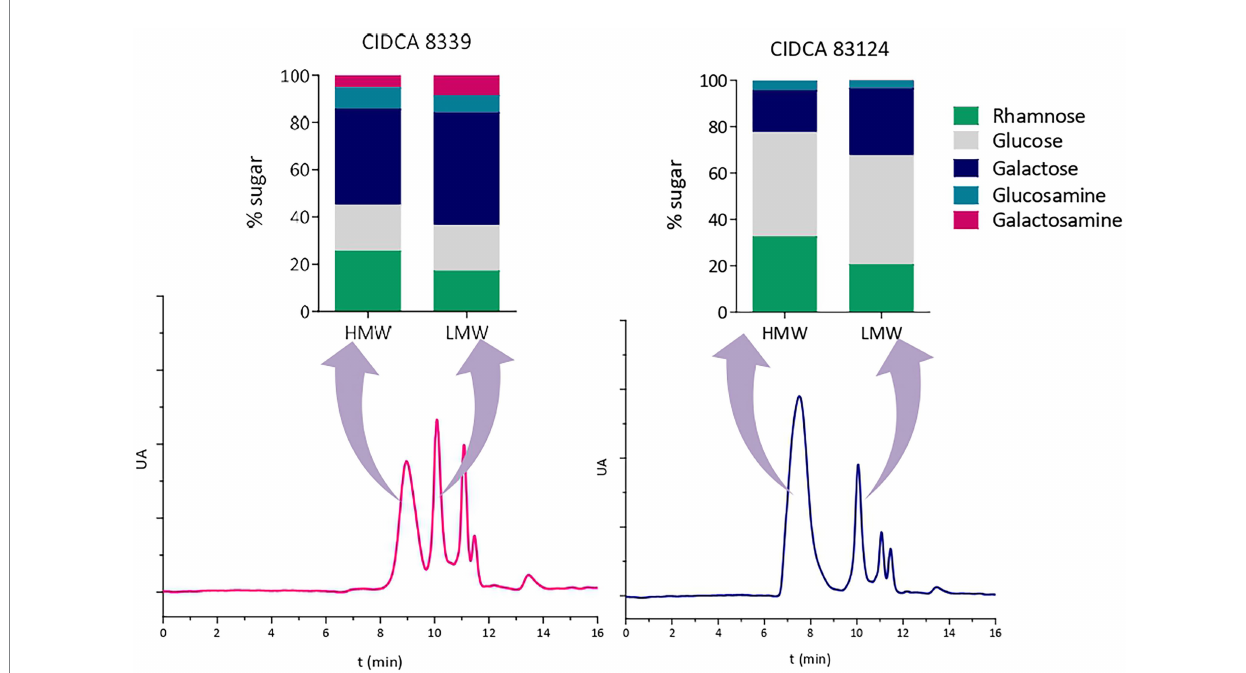
FIGURE 4 High-performance size exclusion chromatograms of EPS isolated from milk produced by L. paracasei CIDCA 8339 and CIDCA 83124 at 20 ° C, and monosaccharide composition of the corresponding high and low molecular weight fractions. AU: arbitrary units. Standard deviation in monosaccharide composition was between 0.4 and 4 depending on the percentage of each monosaccharide.